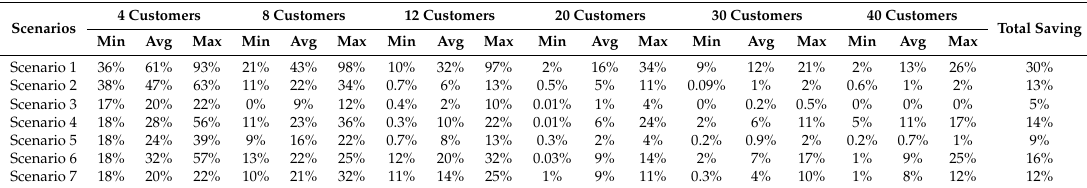
Table 3. Scenario comparison (drone